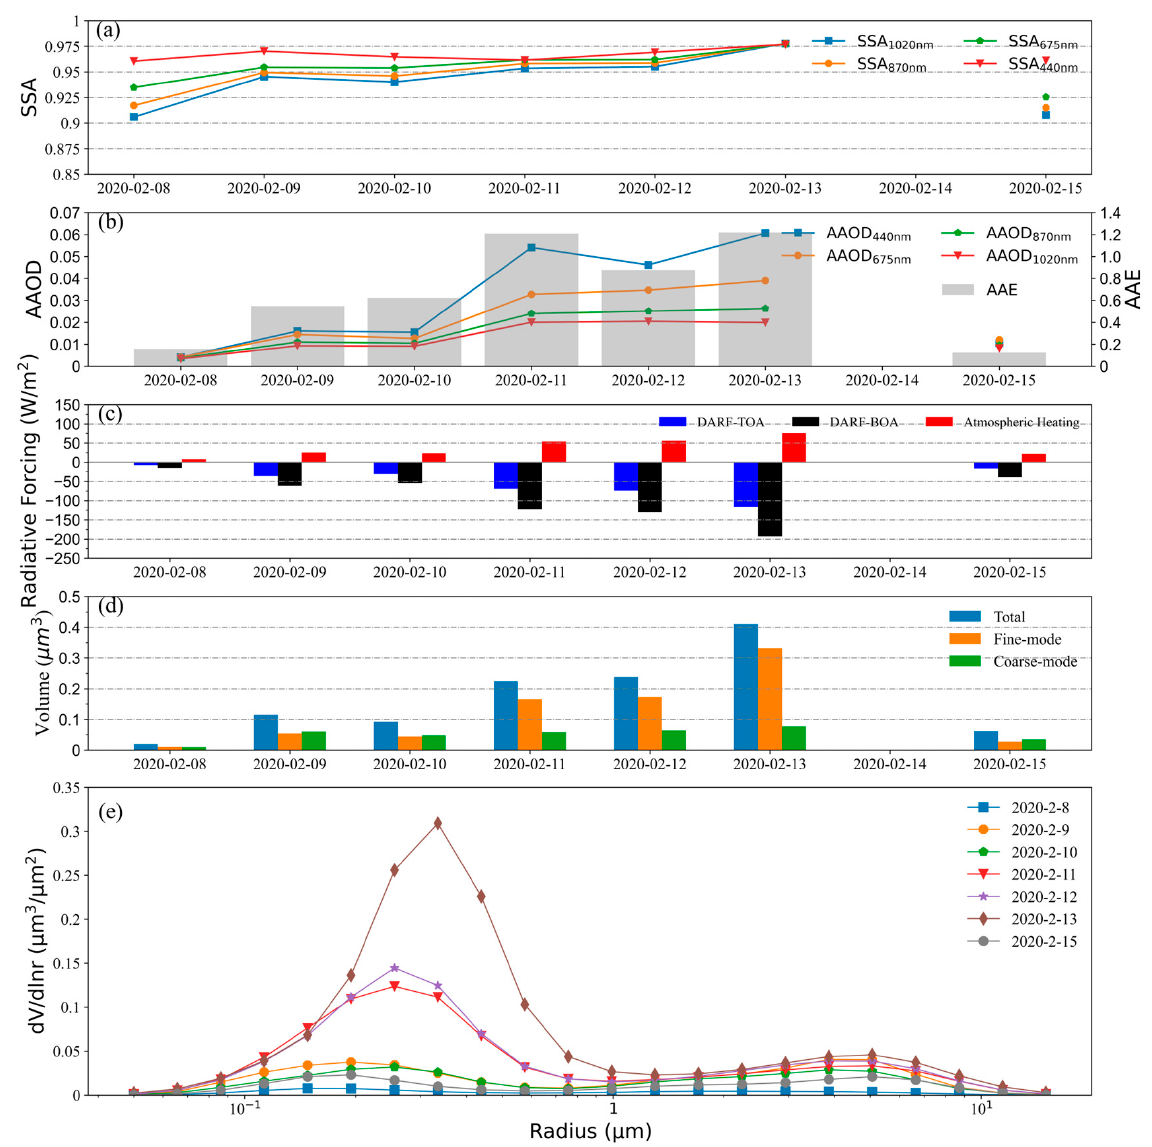
Figure 9. ( a ) The single scattering albedo (SSA), ( b ) the absorbing aerosol optical depth (AAOD) and absorbing Ångström exponent (AAE), ( c ) the direct aerosol radiative forcing (DARF), ( d ) the volume distribution of coarse and fine particles and ( e ) the spectral distribution of the aerosol volume (dV/dln(r)) for the period from 8 February to 15 February 2020 in urban